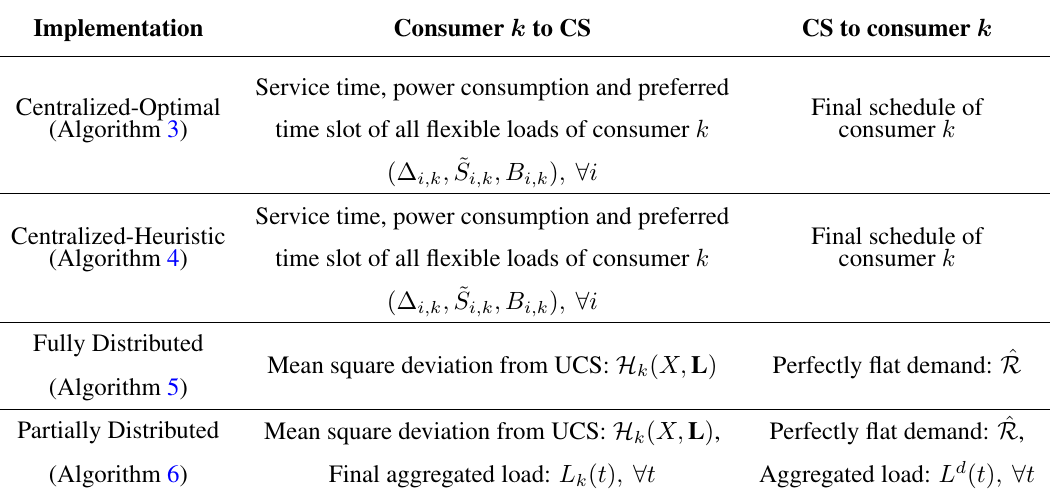
Table 1. Information exchange between CS and consumer k for different